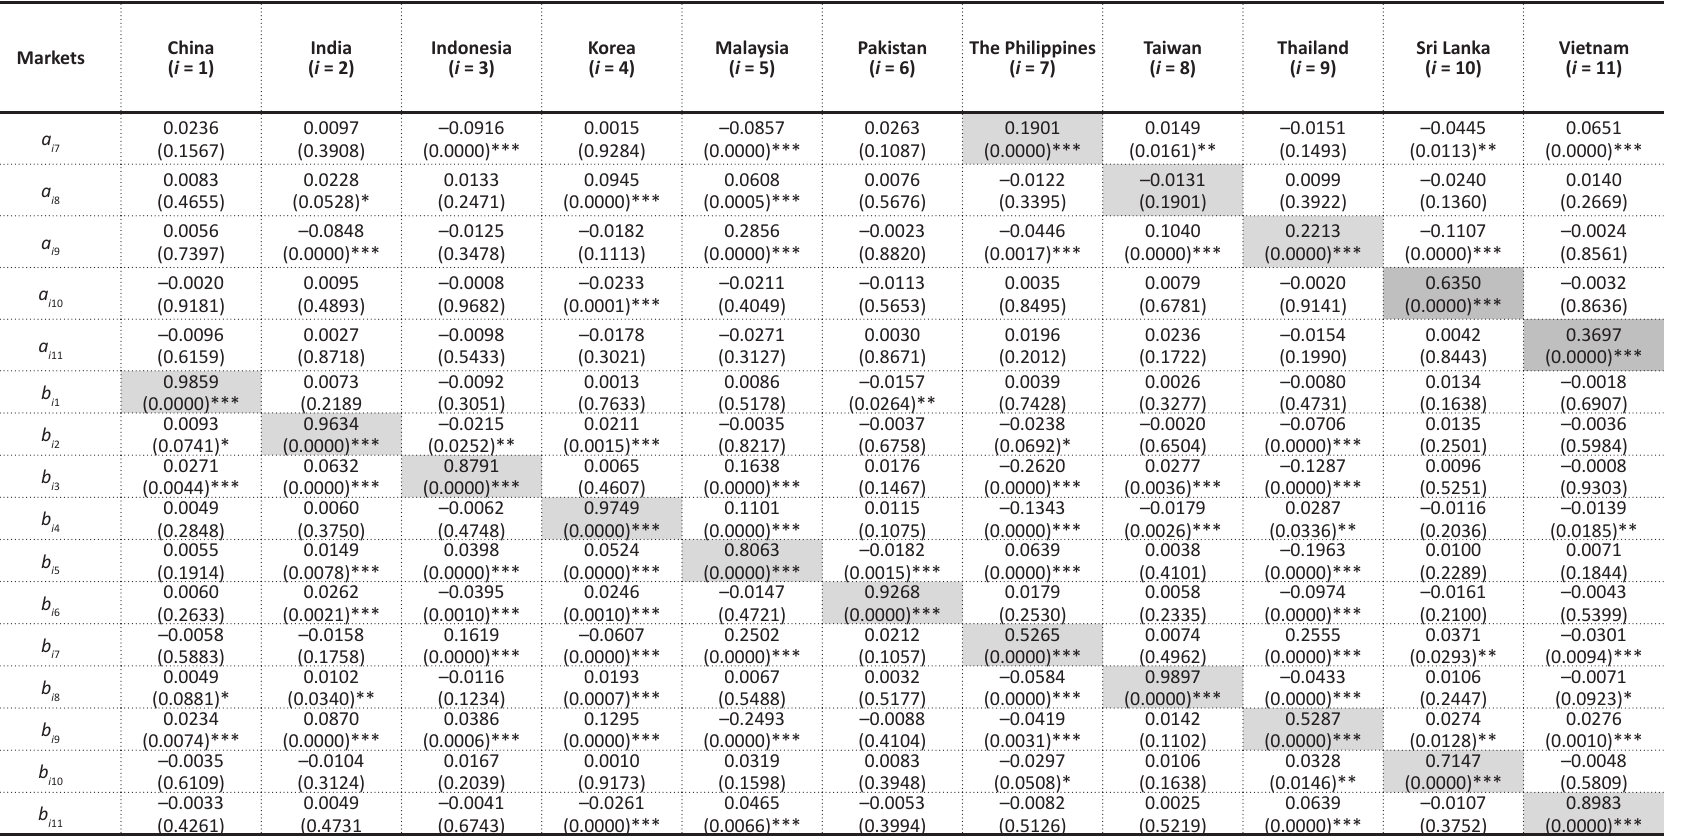
Table 4 (cont.). Shocks and volatility spillover between stock markets during pre-global financial